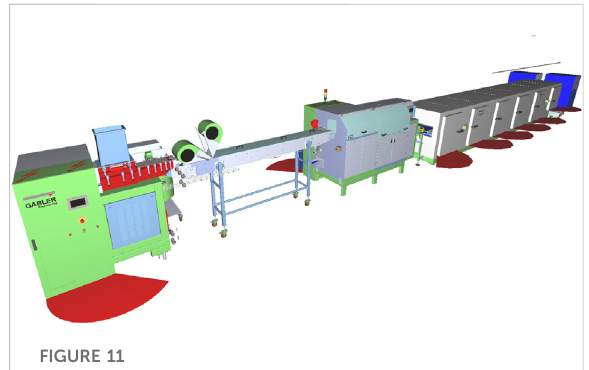
FIGURE 11 Integrated production line for chewing